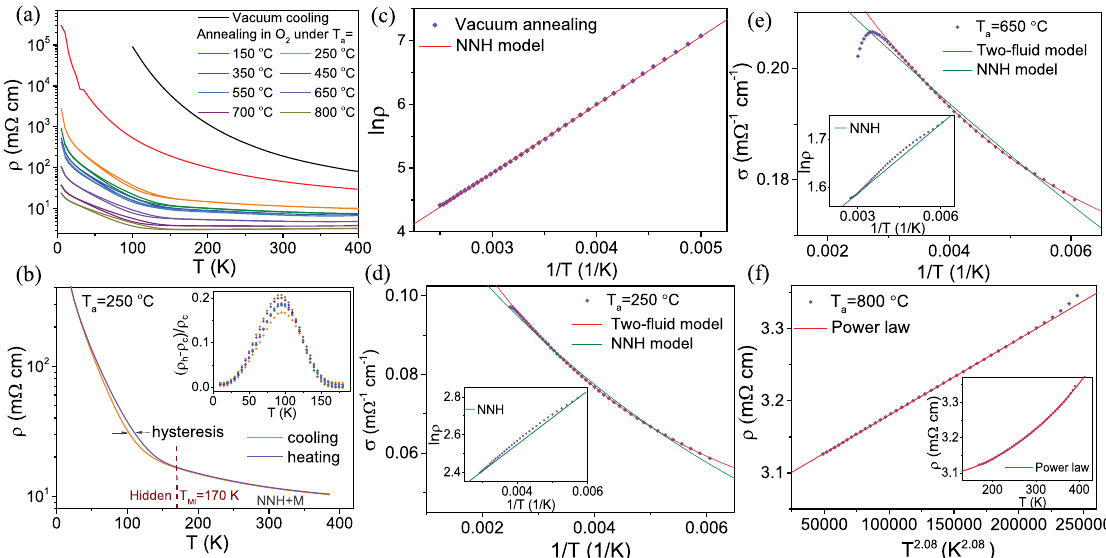
Fig. 1 Modulation of conduction by disorder. a Temperature ( T ) dependence of resistivity ( ρ ) ( ρ - T ) during cooling and heating for the same 20 nm thick NNO thin fi lm grown on an YAO substrate, after annealing at increasingly larger temperatures. b ρ - T measurements during heating ( ρ h ) and cooling ( ρ c ), after annealing at T a = 250 °C. The inset shows the difference between the heating and cooling curves in a . c Ln ( ρ )-1/ T measured in the NNO/YAO fi lm annealed in vacuum, together with the fi t to a NNH model for T ≥ 170 K. After annealing at T a = 250 °C d and 650 °C e , the conductivity ( σ ) versus T fi ts best to the two- fl uid model of Eq. (2) ( n = 1). The insets in d and e plotting ln ρ -1/ T , highlight the inadequacy of a NNH fi tting model. f The same NNO/YAO fi lm after annealing at 800 °C for 1 h displays a metal-like ρ - T (inset) with a scaling exponent n =